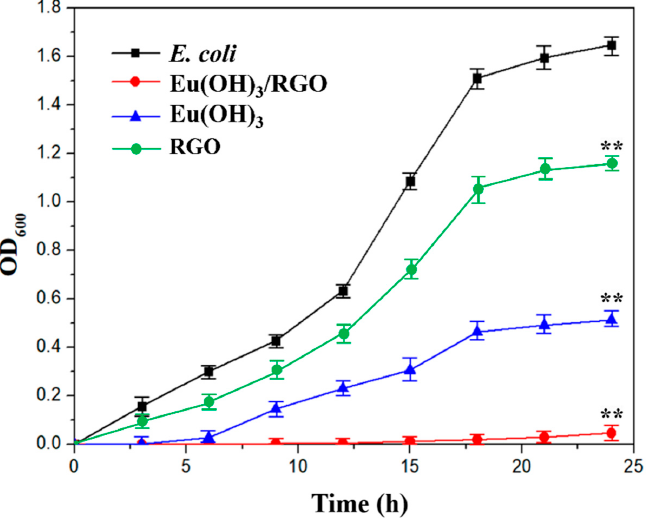
Figure 8. Growth curves of 100 mL E. coli suspension (10 4 CFU/mL) exposed to 0.8 mg (8 µg/mL) of Eu(OH) 3 /RGO, Eu(OH) 3 , and RGO after 3, 6, 9, 12, 15, 18, 21, and 24 h. Error bars represent the standard deviations (n = 3; n = numbers of experimental results); ** p < 0.01 indicates growth curve at 24 h was statistically significant compared with the control group.